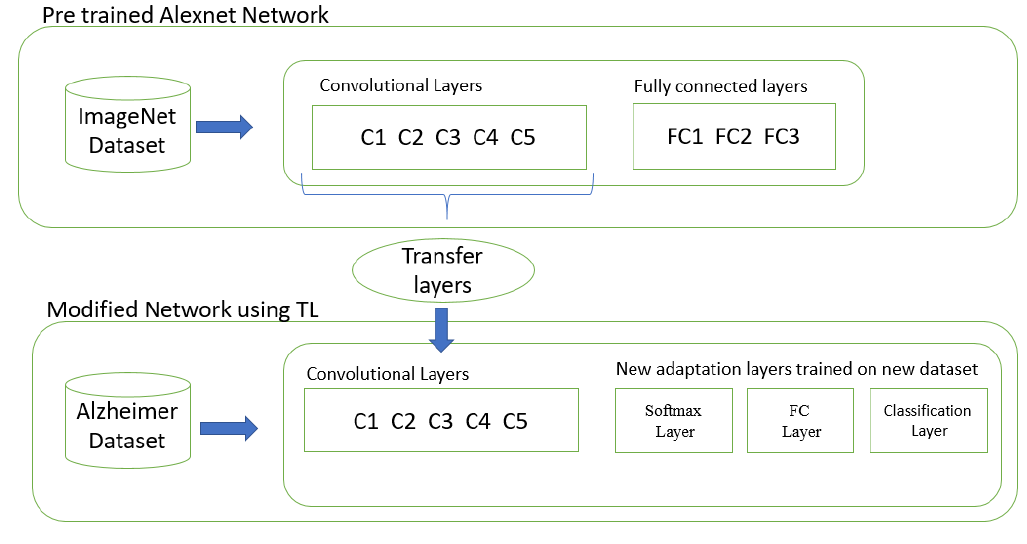
Figure 2. Transferring CNN layers.